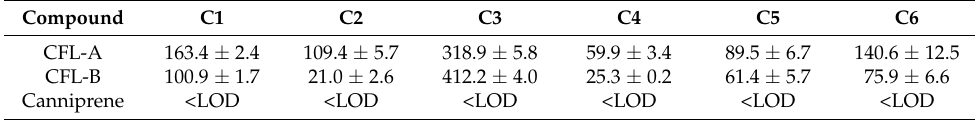
Table 3. Amount ( µ g/g) of the main flavonoids and related compounds in hemp inflorescences a . Compound